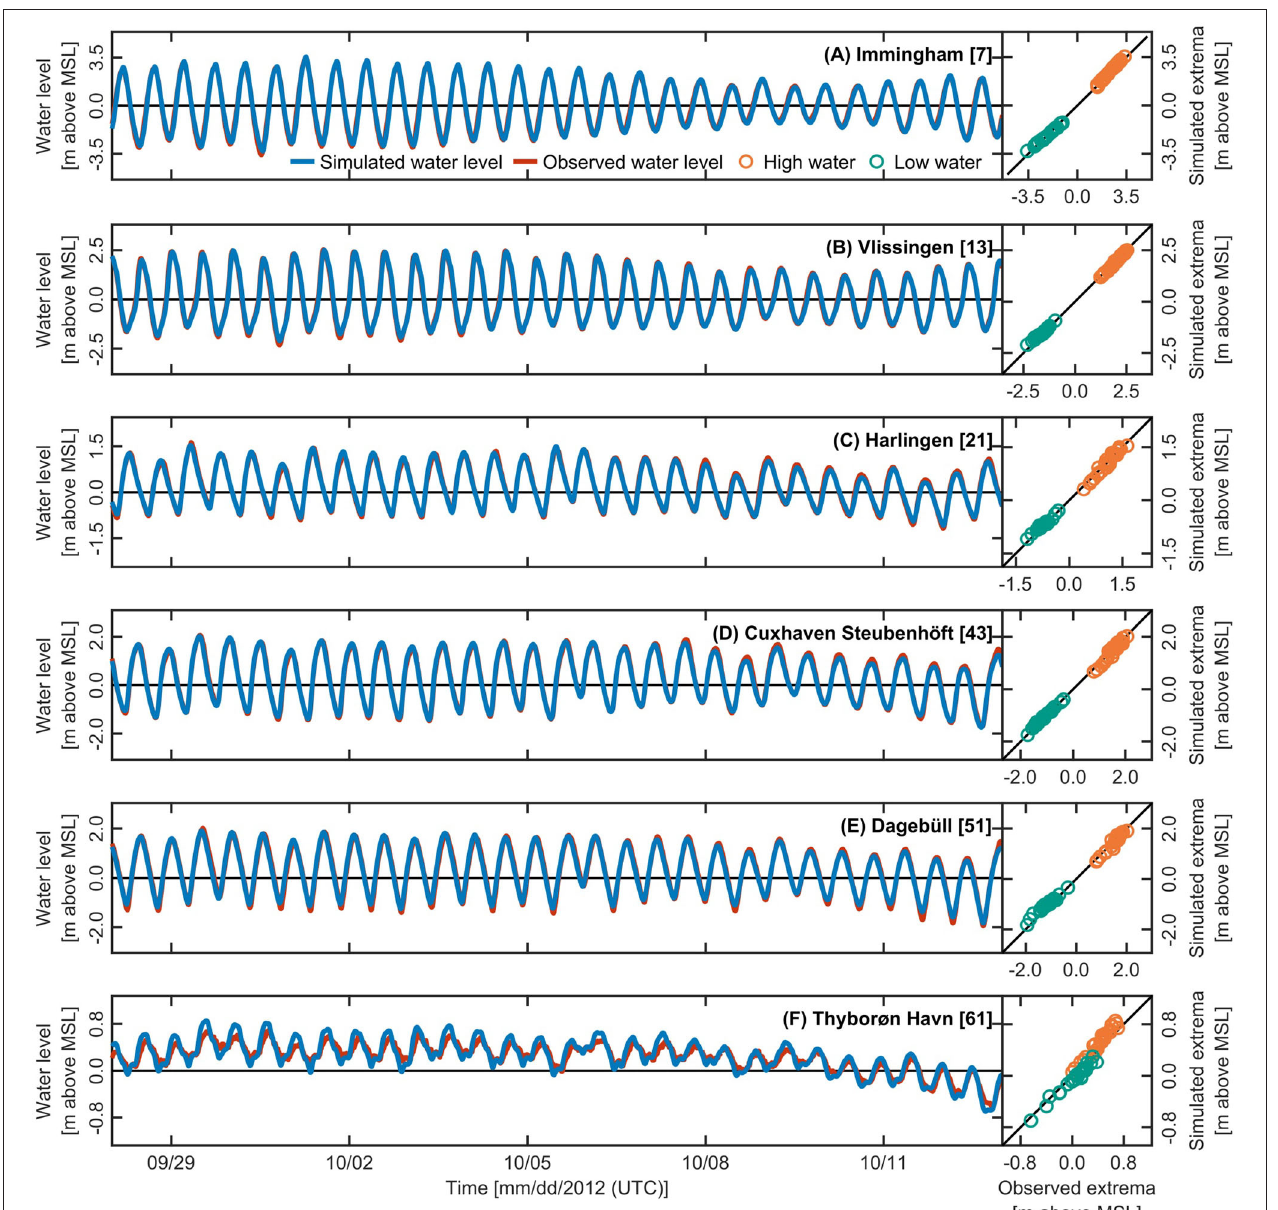
FIGURE 2 | Agreement between simulated and observed water levels at selected tidal gauge stations, according to the spring-neap cycle from September 28 to October 13, 2012. Comparison of simulated and observed water levels at the tidal gauge stations of (A) Immingham, (B) Vlissingen, (C) Harlingen, (D) Cuxhaven-Steubenhöft, (E) Dagebüll, and (F) Thyborøn Havn. Locations of tidal gauges are shown in Figure 1